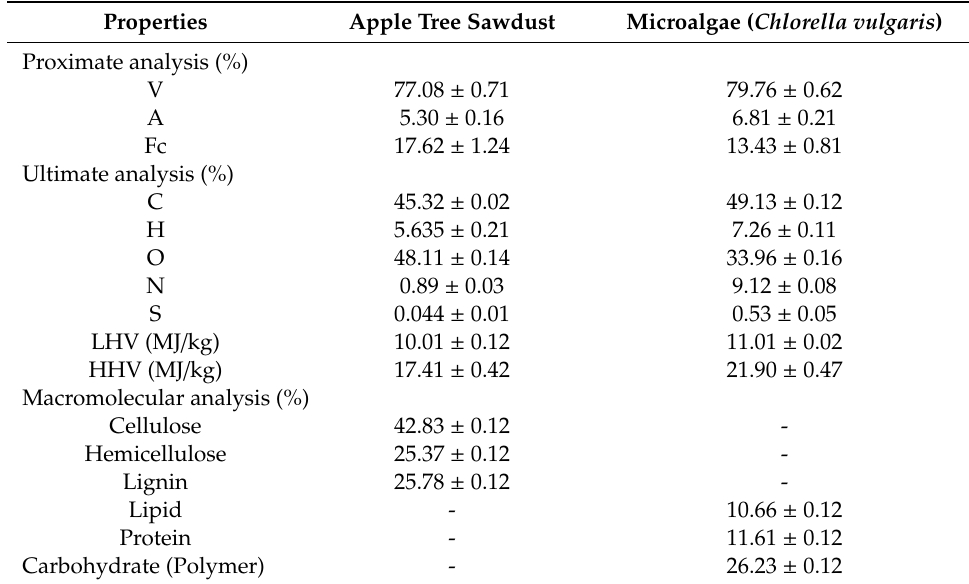
Table 1. Comprehensive analysis result of apple tree sawdust (ATS) and Chlorella vulgaris (CVP; %, on dry ash-free